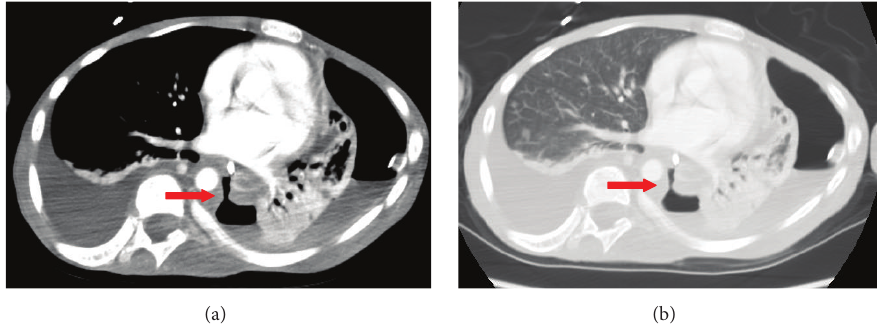
Figure 3: Chest CT with wide window width: (a) mediastinal window, (b) lung window showing esophageal tear and communication with pleura (red arrow).